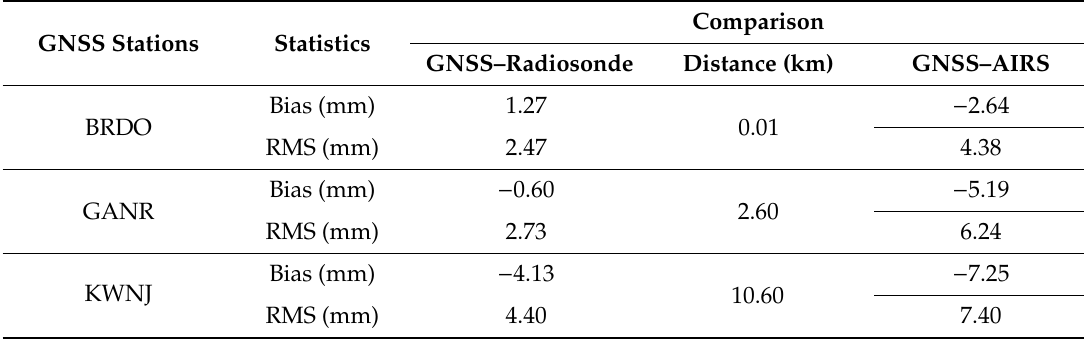
Table 3. Statistical comparison of precipitable water vapor (PWV) retrieval from ground-based